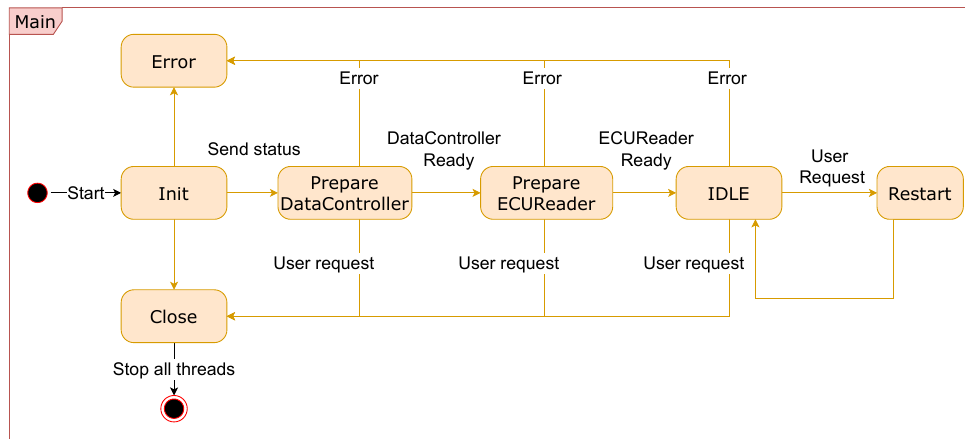
Figure 4. IASE main state